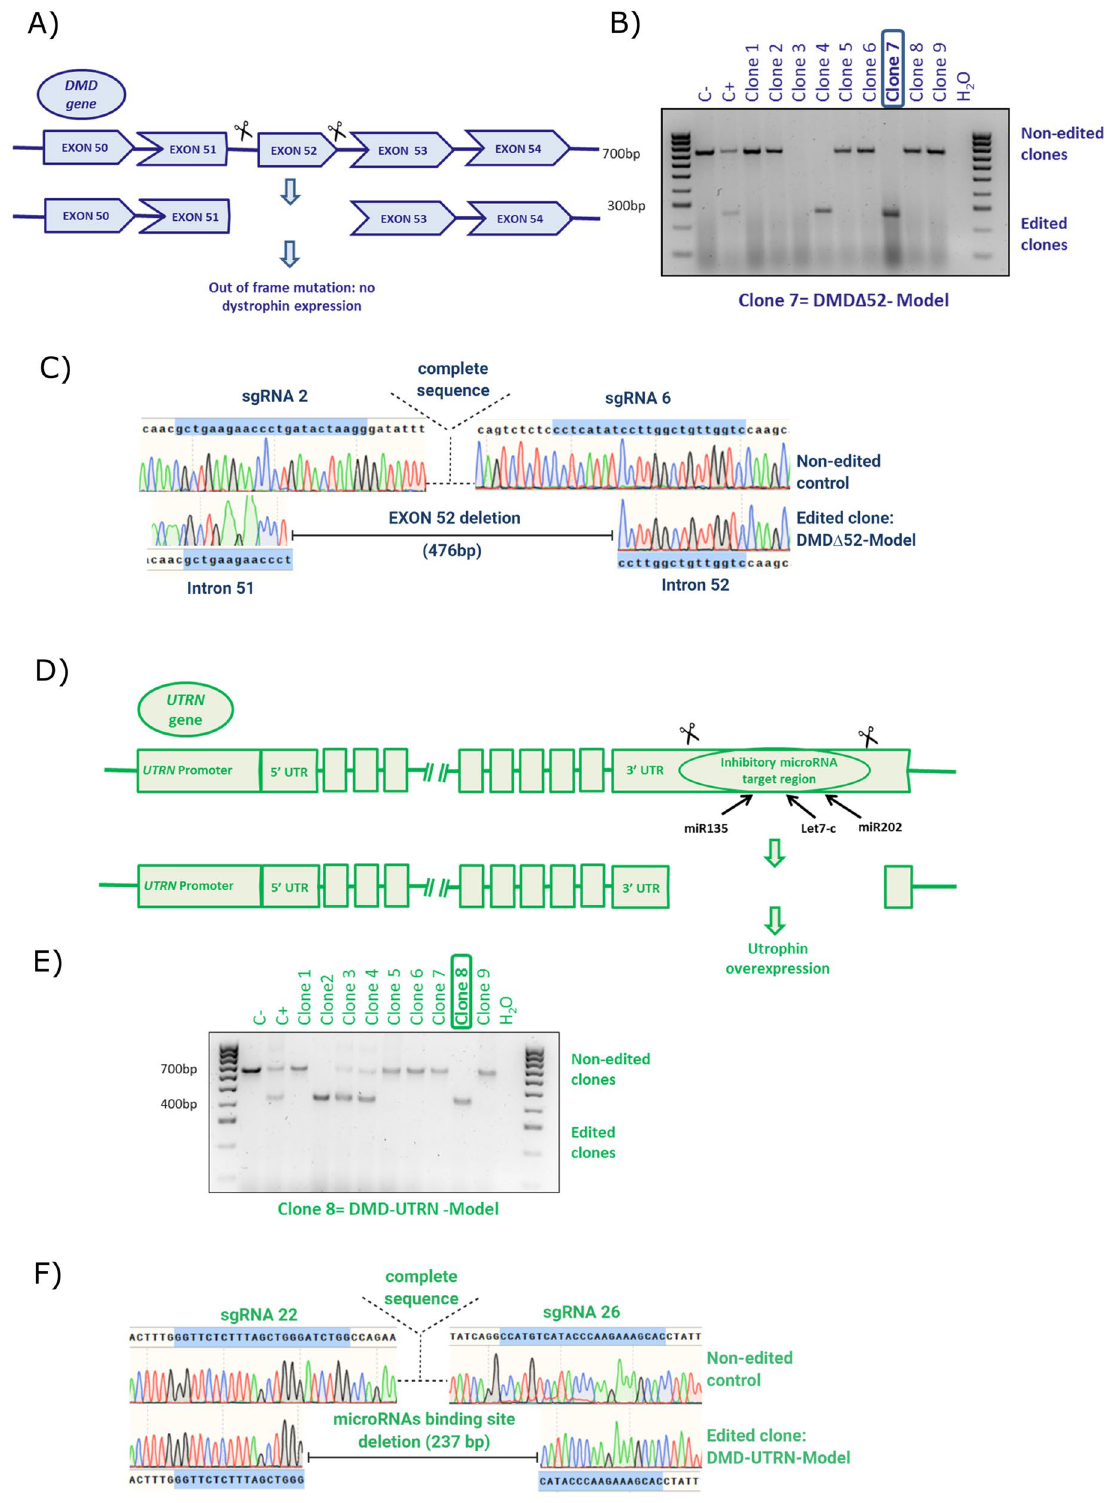
Figure 1. Editing approach and genotyping DMD and UTRN deletion breakpoints in edited myoblast clones. ( A , D ) Schematic representation of our strategy for editing the DMD ( A ) and the UTRN loci ( D ). A pair of flanking sgRNAs were co-transfected in order to delete DMD exon 52 ( A ) or the inhibitory microRNA target region contained in the 5 ′ UTR of UTRN ( D ). ( B , C ) PCR genotyping of DMD edited clones ( B ) and Sanger sequencing of clone 7 or DMD∆52-Model ( C ). ( E , F ) PCR genotyping of UTRN edited clones ( E ) and Sanger sequencing of clone 8 or DMD-UTRN-Model ( F ). Larger products in agarose gels ( B , E ) indicate non-edited clones, and shorter ones correspond with the expected deletion. ( C , F ) Sequences of the smaller bands confirmed the expected gene editing for objective 1: DMD∆52-Model ( C ) and objective 2: DMD-UTRN-Model ( F